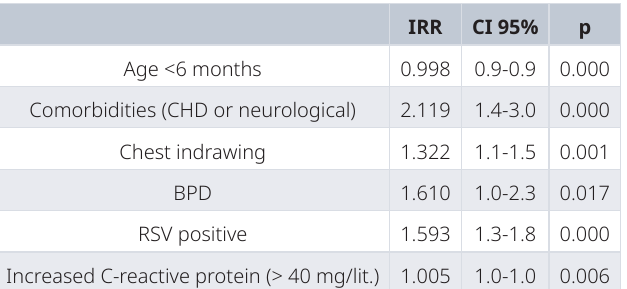
Table 3. Multivariate analysis of predictors associated with length of stay.